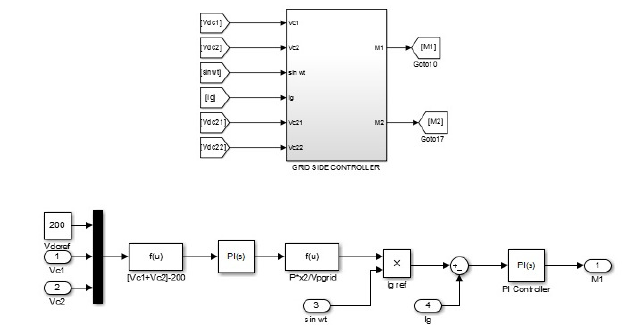
Fig.11: Simulink model of grid side controller